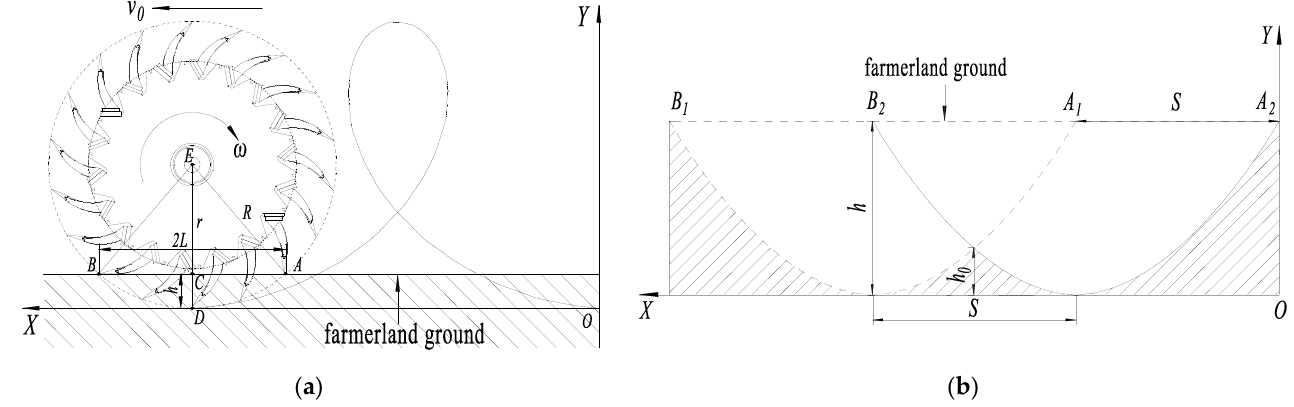
Figure 4. Motion analysis of the tooth roller device. ( a ) Movement trail of the arc-shaped nail- tooth; ( b ) analysis of continuous work process. ( b ) analysis of continuous work